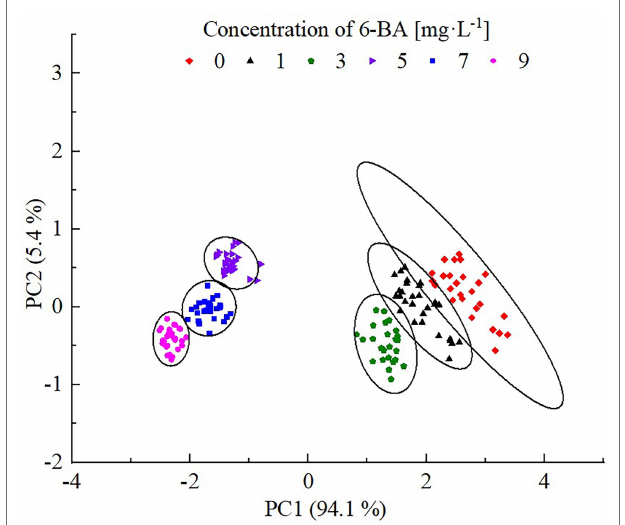
FIGURE 5 | PCA scores of soybean sprouts cultured with different concentrations of 6-BA. Each dot represents a sample; each color represents a 6-BA